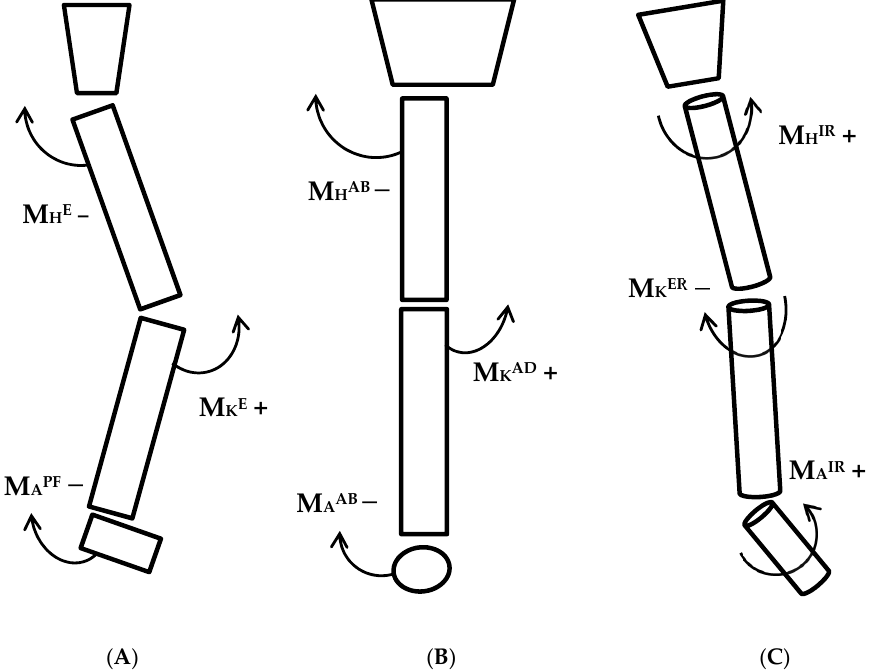
Figure 1. Left to right; sagittal ( A ), frontal ( B ), and transverse ( C ) plane representation of the hip, knee, and ankle joint moments during limb support. Counterclockwise moments (+) and clockwise moments ( − ). Sagittal plane ankle plantarflexor (M A PF ), knee extensor (M K E ), and hip extensor (M H E ) moments contribute to an extensor support moment. Frontal plane ankle abductor (M A AB ), knee adductor (M K AD ), and hip abductor (M H AB ) moments resist medial knee opening. Transverse plane ankle internal rotator (M A IR ), knee external rotator (M K ER ), and hip internal rotator (M H IR ) moments resist internal rotation of the